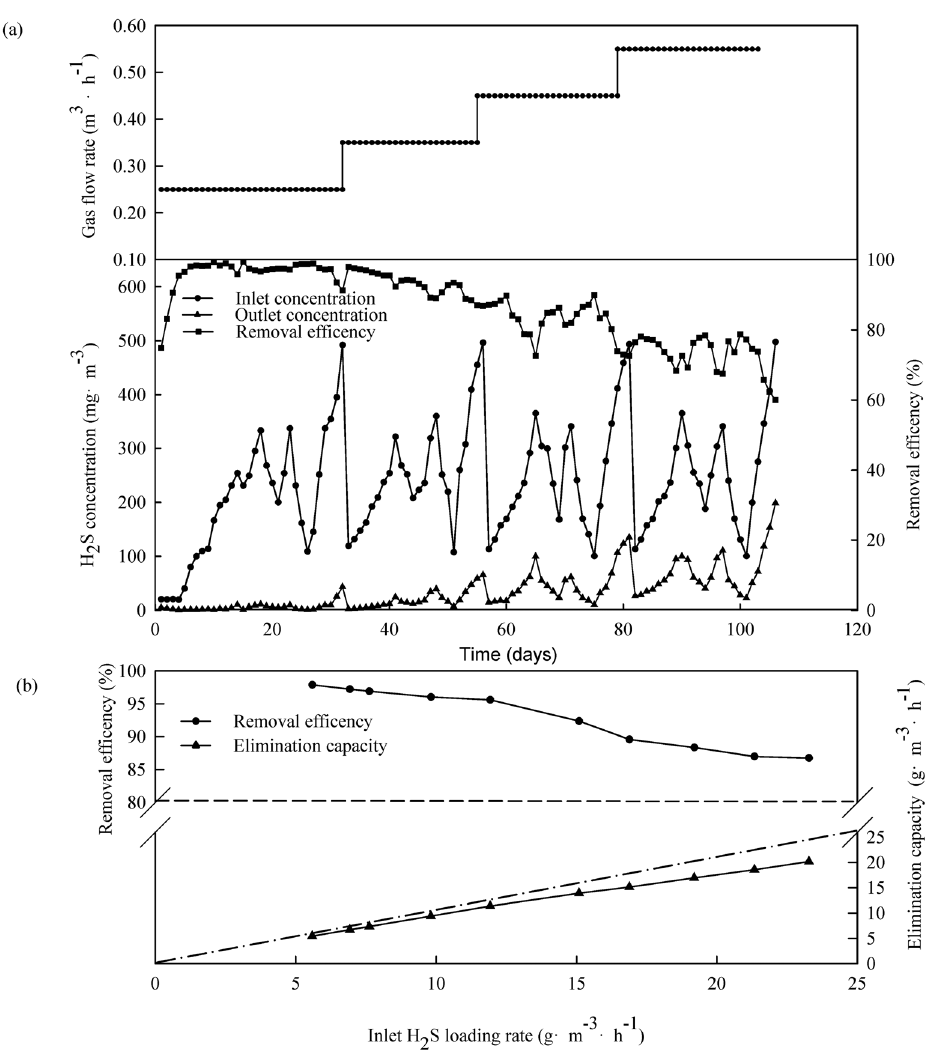
Figure 2: ( a ) Removal performance for hydrogen sul fi de in the vermicompost - packed bioreactor at di ff erent gas fl ow rates and inlet H 2 S concentration and ( b ) in fl uence of inlet loading on the elimination capacity and removal e ffi